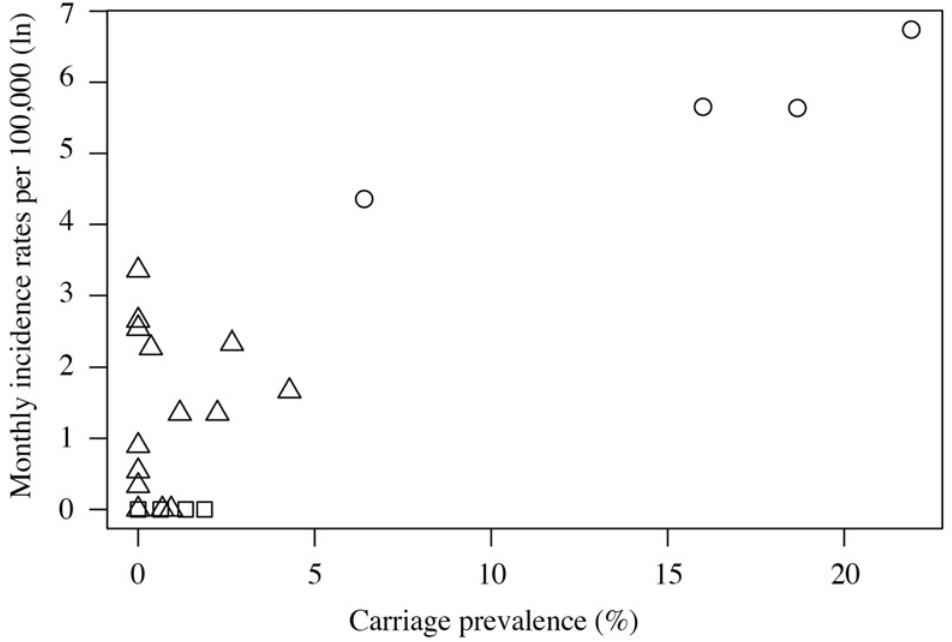
Figure 3. Scatterplot of meningococcal serogroup A monthly incidence rates and carriage prevalence across case carrier observation units. Squares show data points in endemic context; triangles show data points in hyperendemic context, and hallow circle show data points in epidemic